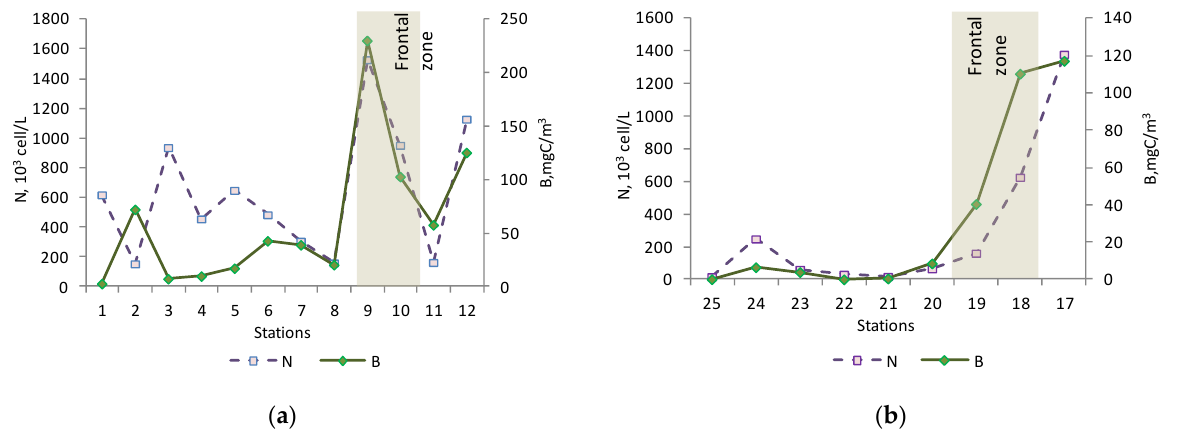
Figure 4. Distribution of abundance (N) and biomass (B) of phytoplankton in the study area at stage 1 ( a ) and stage 2 ( b ).